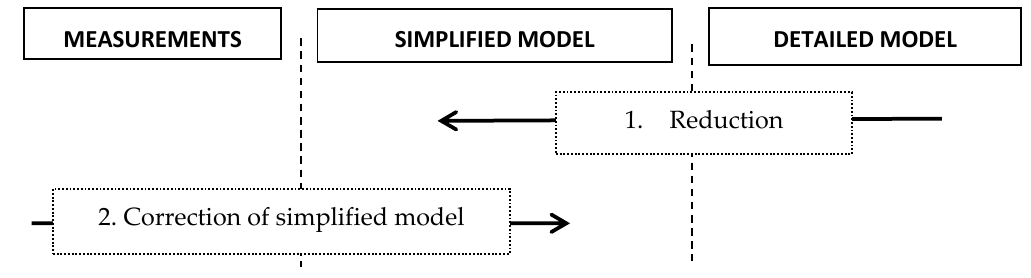
Figure 1. Basic principles of methodology.